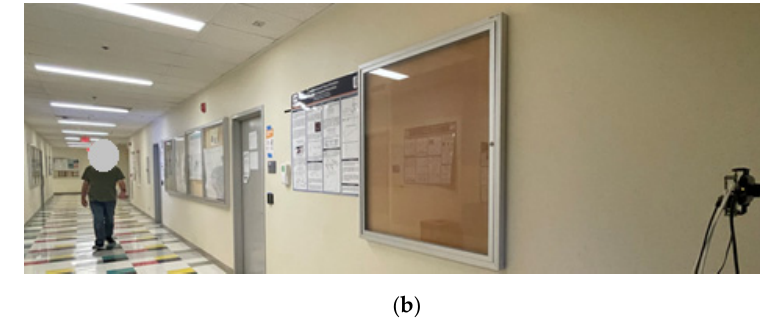
Figure 8. Data collection for the practical testing showing the subjects ( a ) standing for the heart sound scans and ( b ) walking for the gait scans.